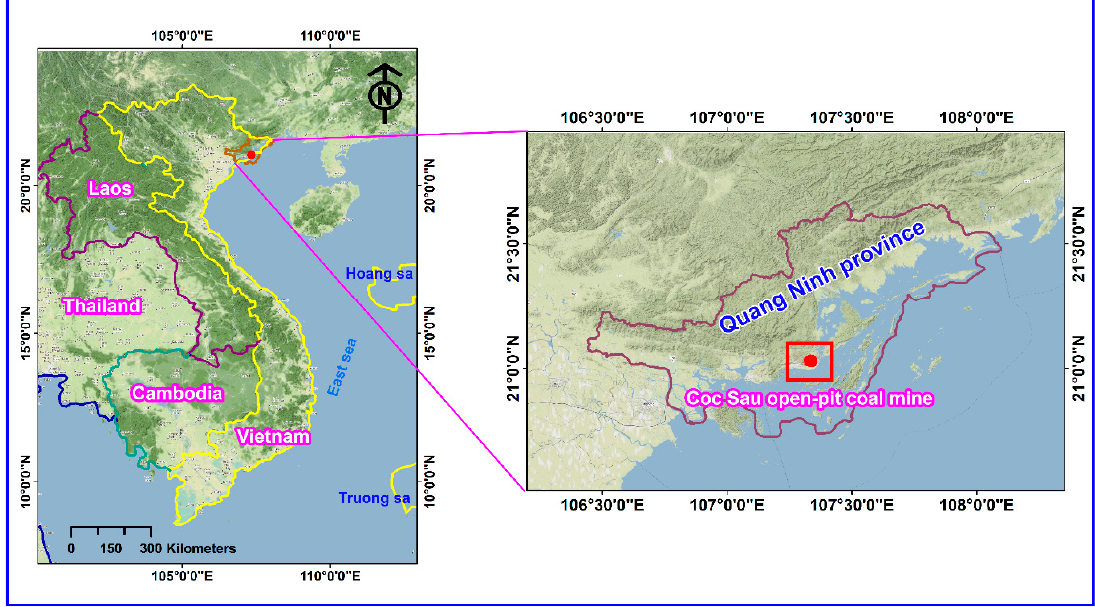
Figure 1. Location of the study site.